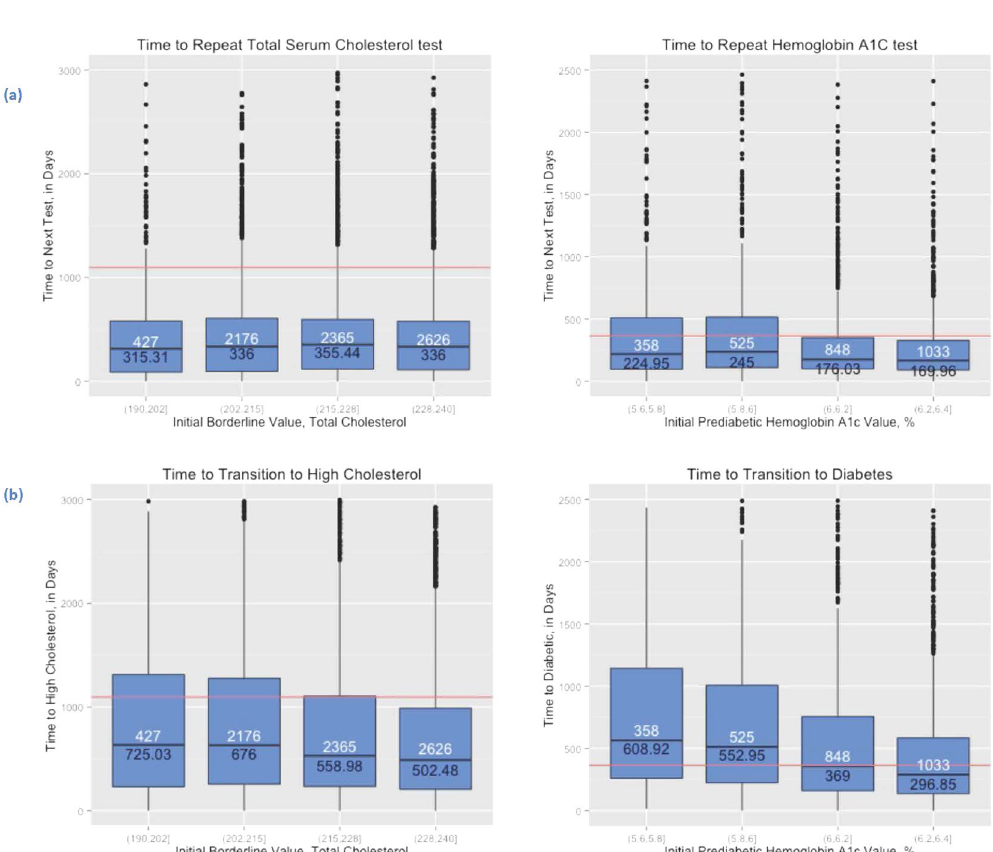
Figure 1. ( a ) Time between first pre-disease test result and retest. Red line indicates the recommended time to retest for pre-disease patients. Median time to retest is shown in black, with the number of patients shown in white. 91% of patients (n = 6892) are tested for total cholesterol within guidelines. 73% of patients (n = 2009) are tested for HA1c within guidelines. ( b ) Time between first pre-disease test result and transition to full disease state. Red line indicates the recommended time to retest for pre-disease patients. Median time to retest is shown in black, with the number of patients shown in